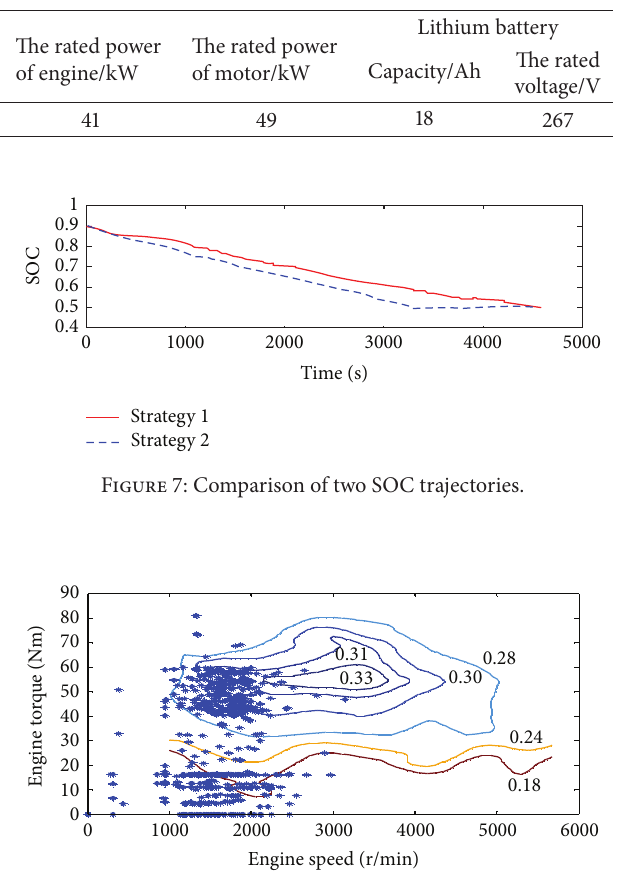
Figure 5: Flow chart of DP algorithm.